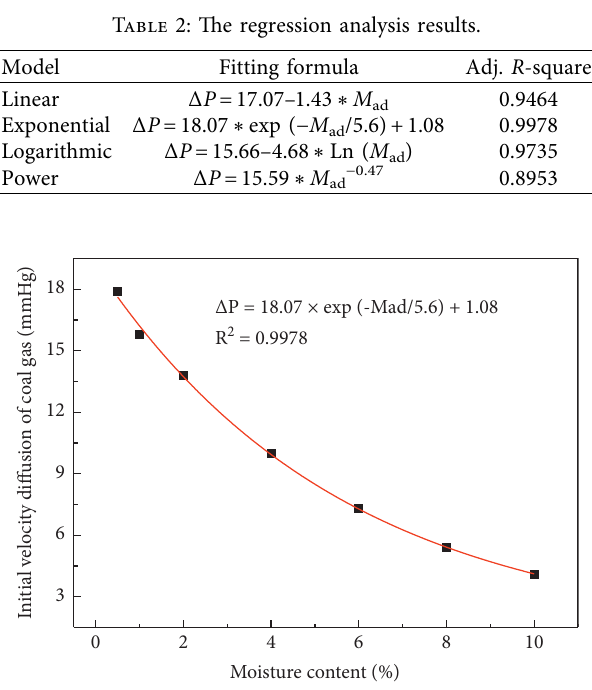
Figure 9: Te relationship between IVDCG and equilibrium moisture